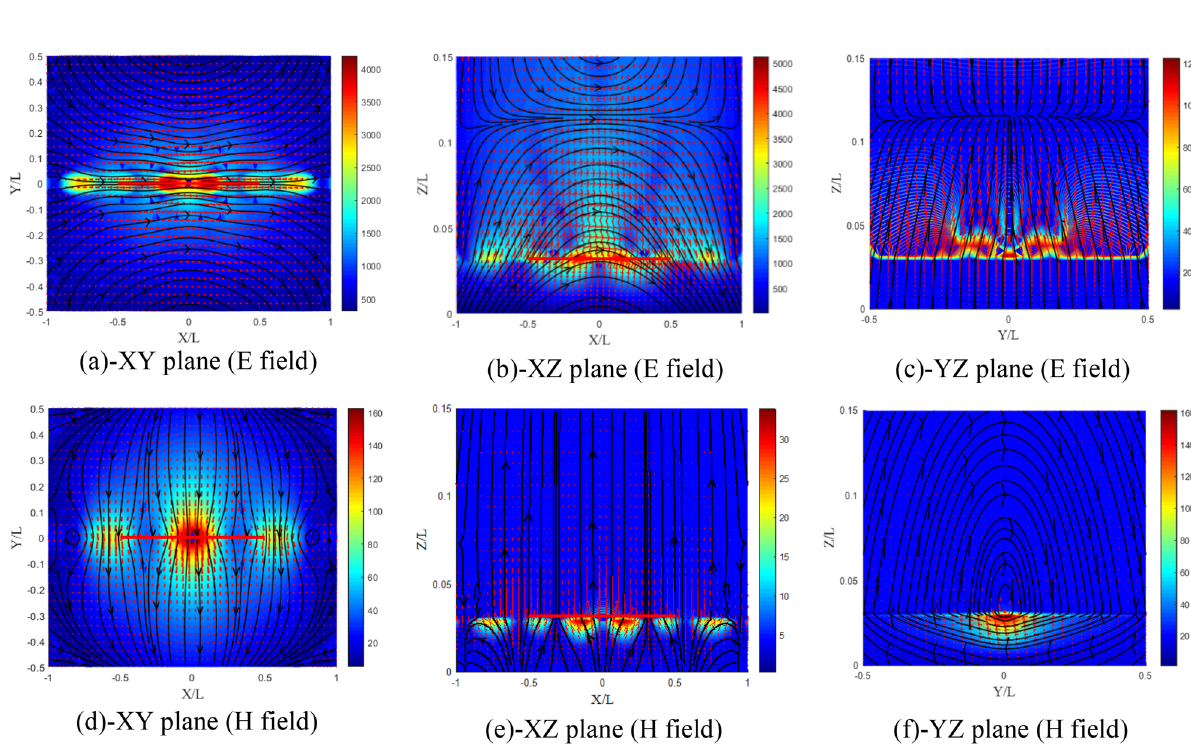
η xy ) case, ( a – c ) electric and ( d – f ) = −